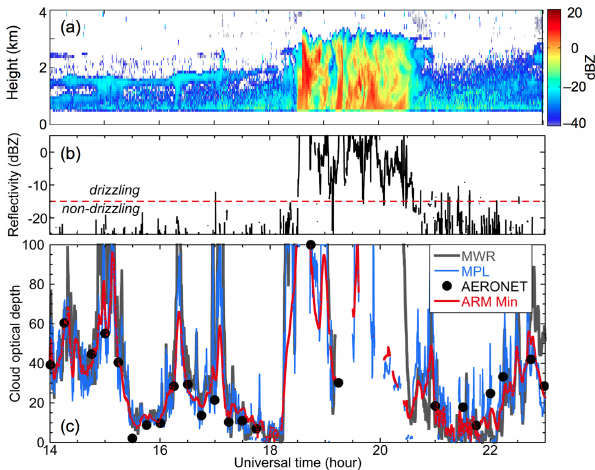
Figure 5. Same as Fig. 4, but for 2 May 2007. Heavy precipitation occurs at 18:30–20:30UTC.